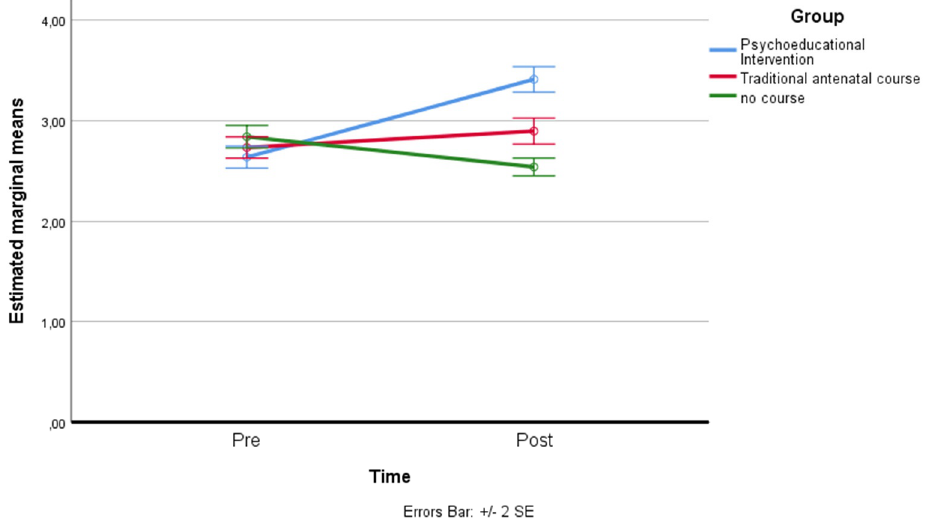
Figure 3. Estimated marginal means of perceived self-efficacy.